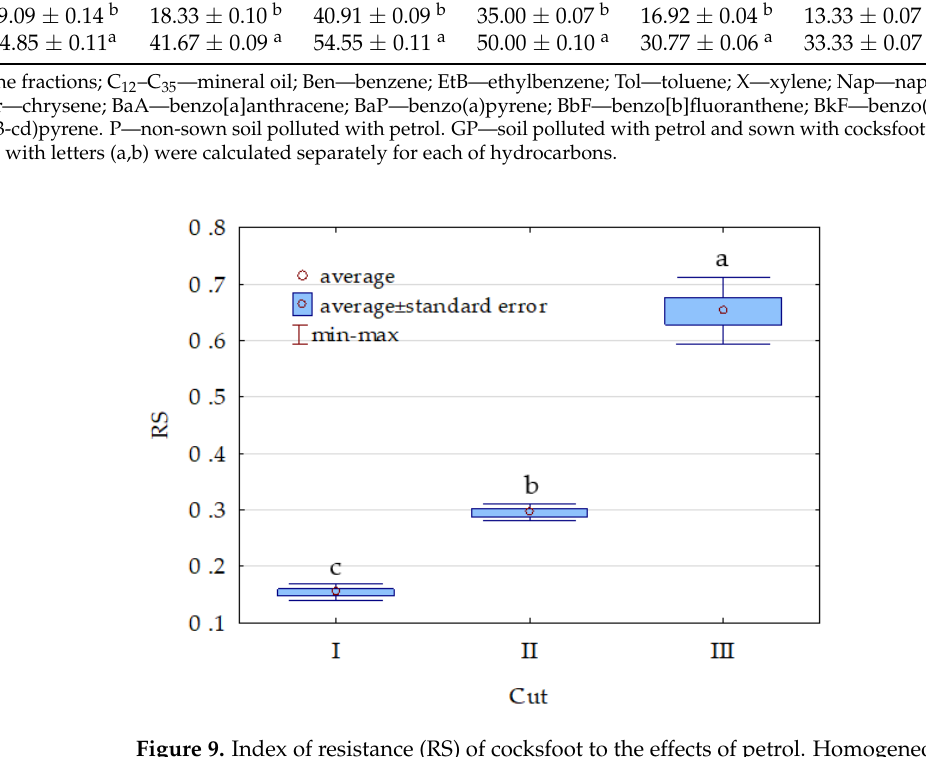
Figure 9. Index of resistance (RS) of cocksfoot to the effects of petrol. Homogeneous groups denoted with letters (a,b,c) were calculated separately for each of